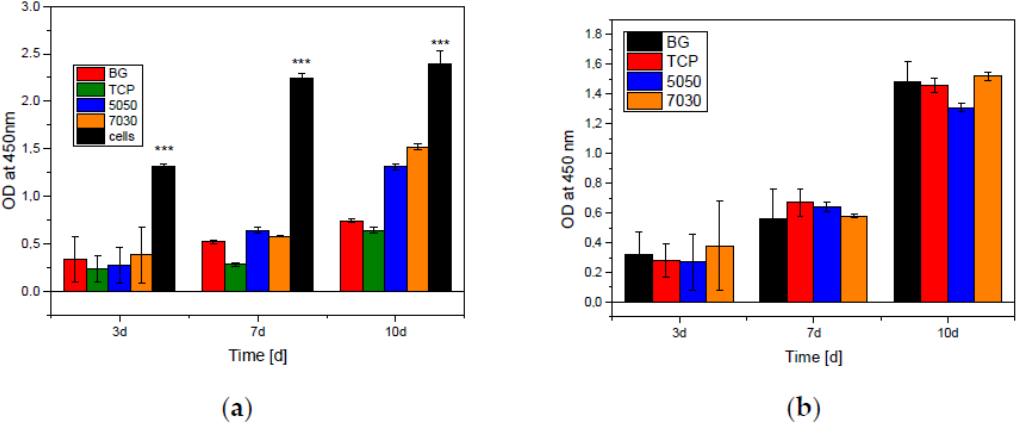
Figure 8. Differences in WST-1 Assay of MG-63 cells after cultivation on the different samples after 3, 7 and 10 days. Cell culture grade plastic was used as a control. Significant difference *** ( p = 0.001). ( a ) Cells on the Scaffolds, after removing it out of the cell culture plates; and ( b ) cells remaining in the same cell culture plates, which were moving through the pores of the 3D printed scaffolds and settled at the walls of the cell culture plate ( n = 30).